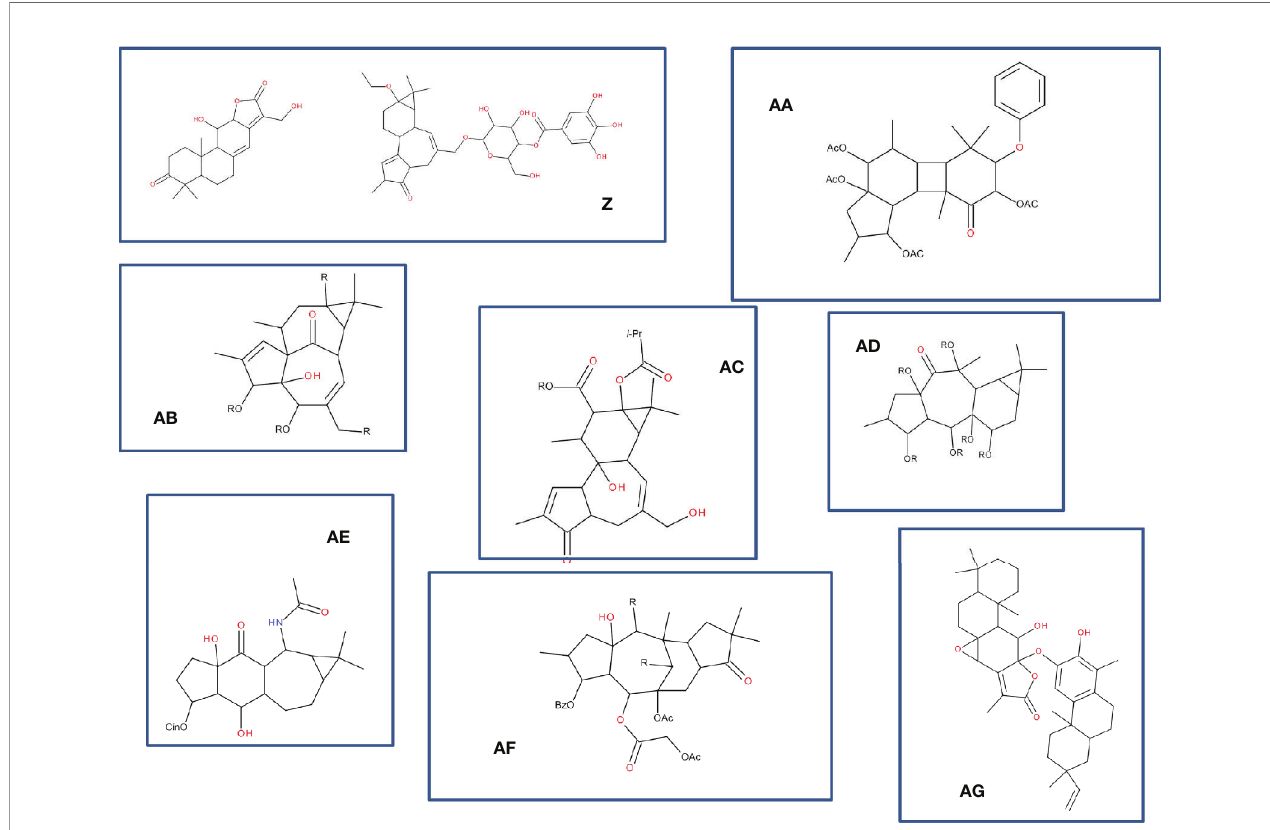
FIGURE 4 | Variations around diterpenoids found in six species of Euphorbia . Compounds were drawn from the works on Euphorbia . Z : ent-abietane-type diterpenoid ( Z 1) and a tiglane ( Z 2) (Wang et al., 2017); AA : gaditanone (Flores-Giubi et al., 2017); AB : ingenane-type diterpenoid, euphorkan A (Zhang et al.,